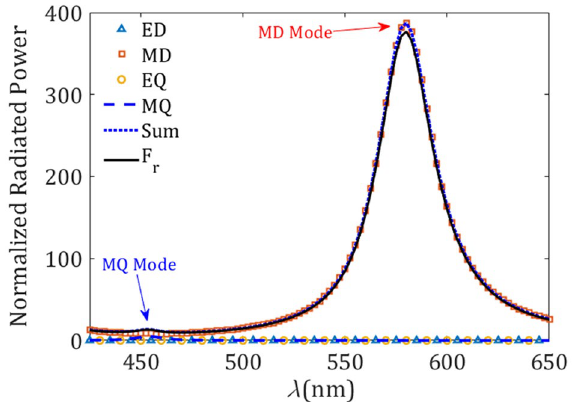
Figure 3. Modal radiative power as given in Eq. (3), normalized to the free-space radiation power P 0 , corresponding to the lowest-order modes excited in the spherical silicon resonator with R MD emitter. Other geometrical parameters are d